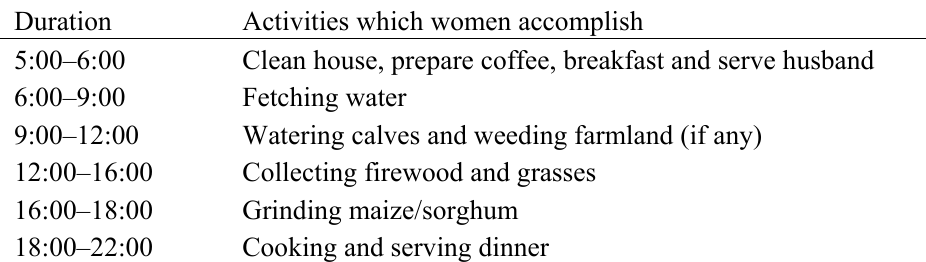
Table 3. Daily routines of pastoral